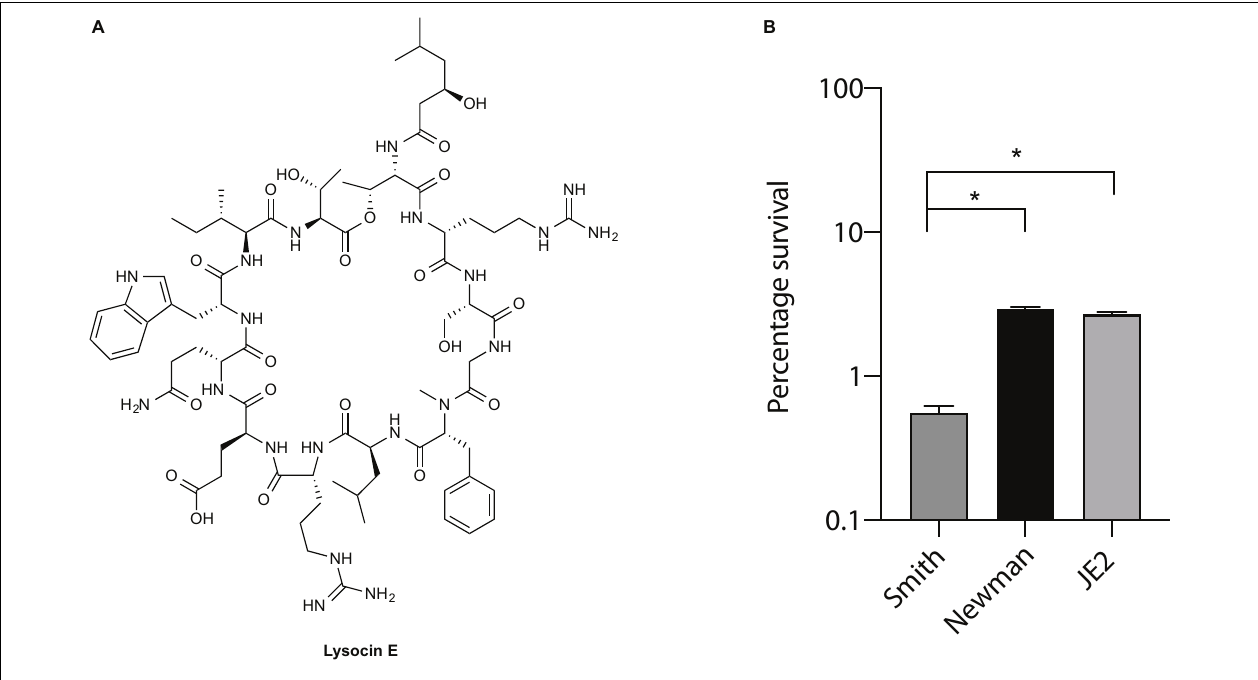
FIGURE 1 | Lysocin E and its antimicrobial activity. (A) Chemical structure of lysocin E. (B) Bactericidal activity of lysocin E. S. aureus strains were treated with 1 mg/L lysocin E for 30 min, and bacterial viability was determined. Triplicate data are represented as mean ± SEM and statistical analysis was performed by one-way ANOVA using Dunnett’s multiple comparison test in GraphPad Prism. The asterisk indicates a p -value of < 0.0001.